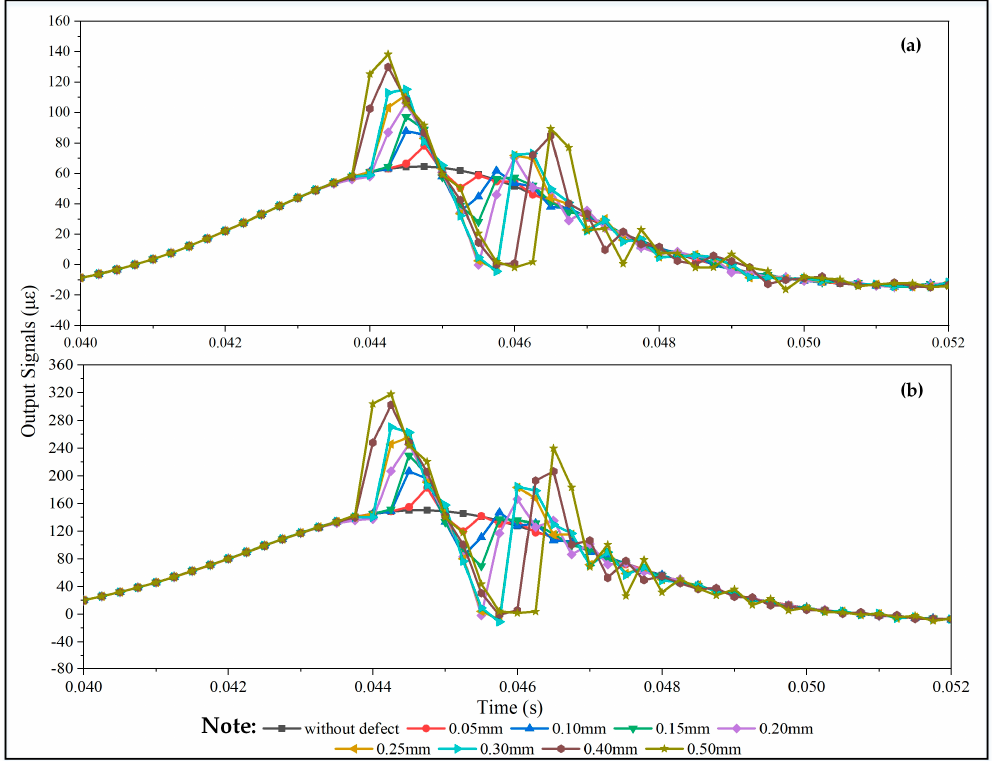
Figure 7. Sensitivity of sensor layout schemes to wheel flats of different defect conditions: ( a ) Rail web bending moment method; ( b ) rail web compression method.